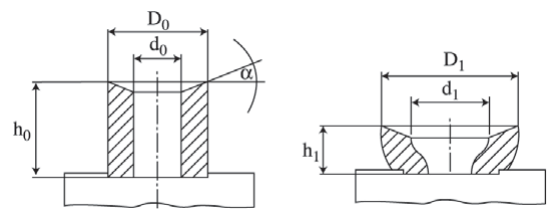
Figura 3. Corpo de prova para ensaio do tubo cônico 6 .